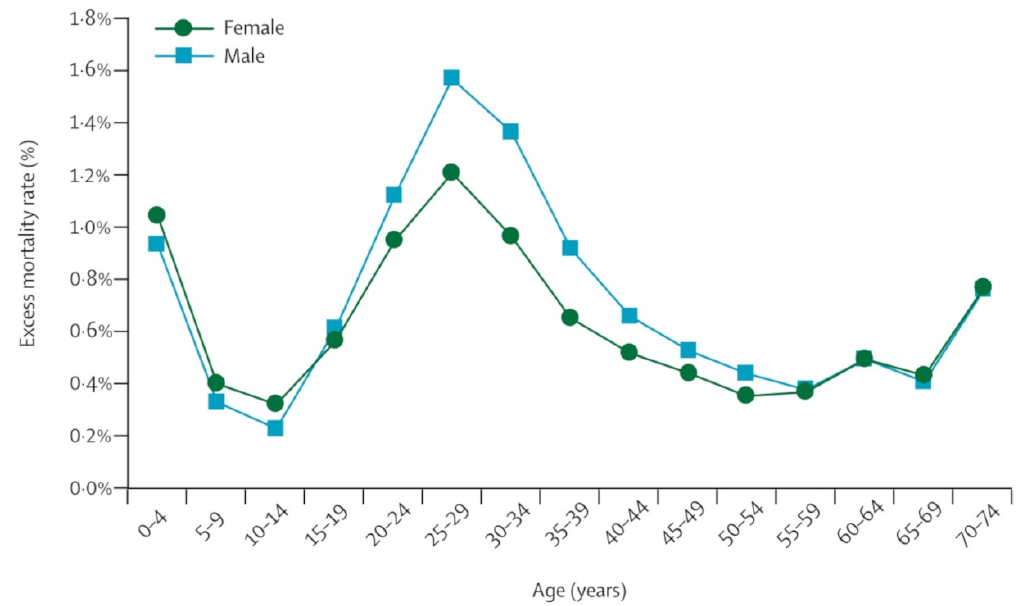
Figure 4. Median excess mortality rate by age and sex for the 1918–1920 flu pandemic based on data from 13 countries with available data. Source: This figure was published in The Lancet , 368, Christopher J L Murray, Alan D Lopez, Brian Chin, Dennis Feehan, Kenneth H Hill, Estimation of potential global pandemic influenza mortality on the basis of vital registry data from the 1918–20 pandemic: a quantitative analysis, 2211–2218, Copyright Elsevier Ltd. 2006 [84].